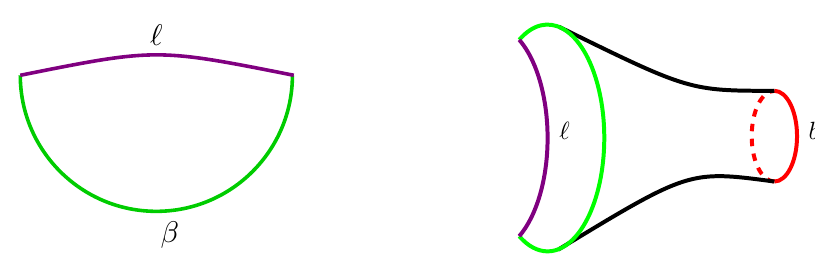
Figure 1 . Left : the wavefunction of the Hartle-Hawking state of the two-sided AdS system in JT gravity. Green denotes an asymptotic boundary, while the violet one is the geodesic connects to two different points on the asymptotic boundary. Right : the wavefunction of the Hartle-Hawking state of a trumpet. The closed geodesic boundary is depicted in